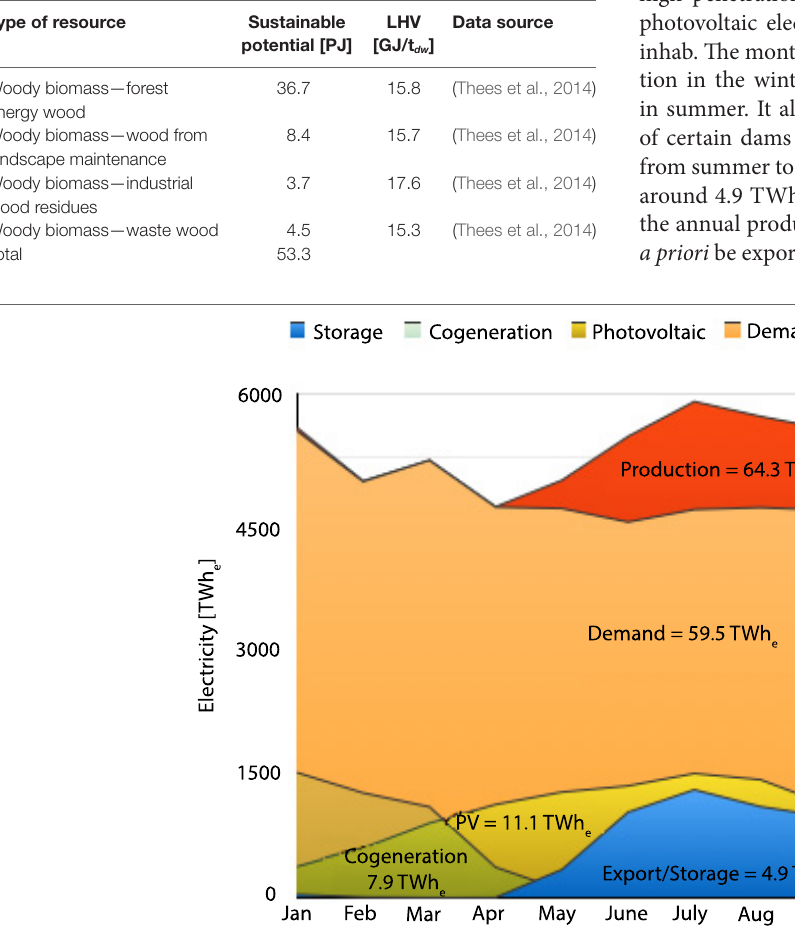
FigUre 8 | Swiss electricity production and consumption in the NEP scenario for 2050.